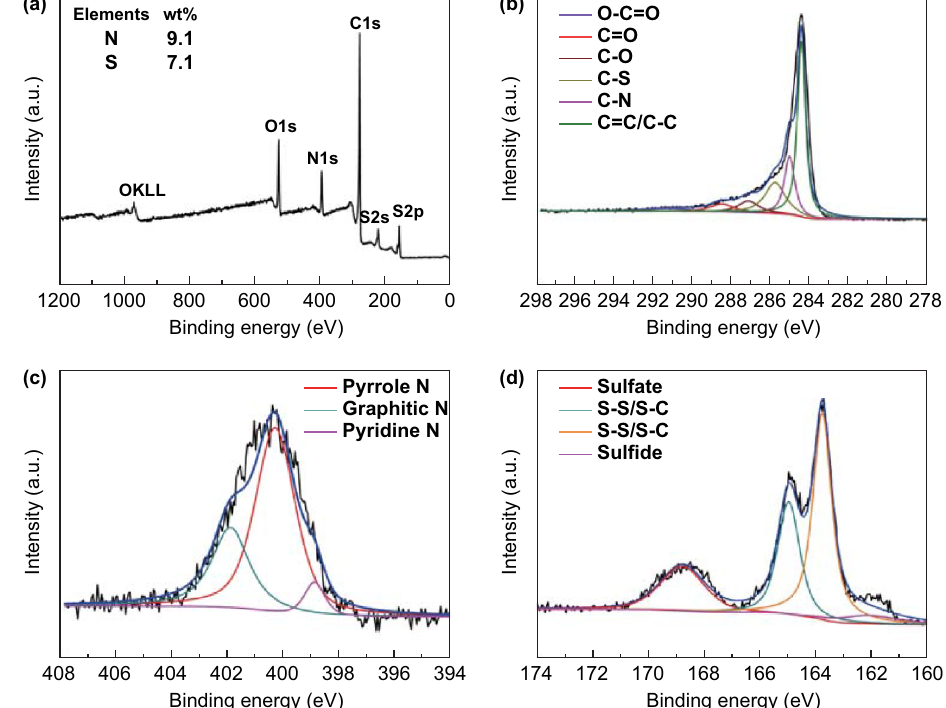
Fig. 3 a XPS spectrum of N,S-G and high-resolution b C 1 s , c N 1 s , and d S 2 p